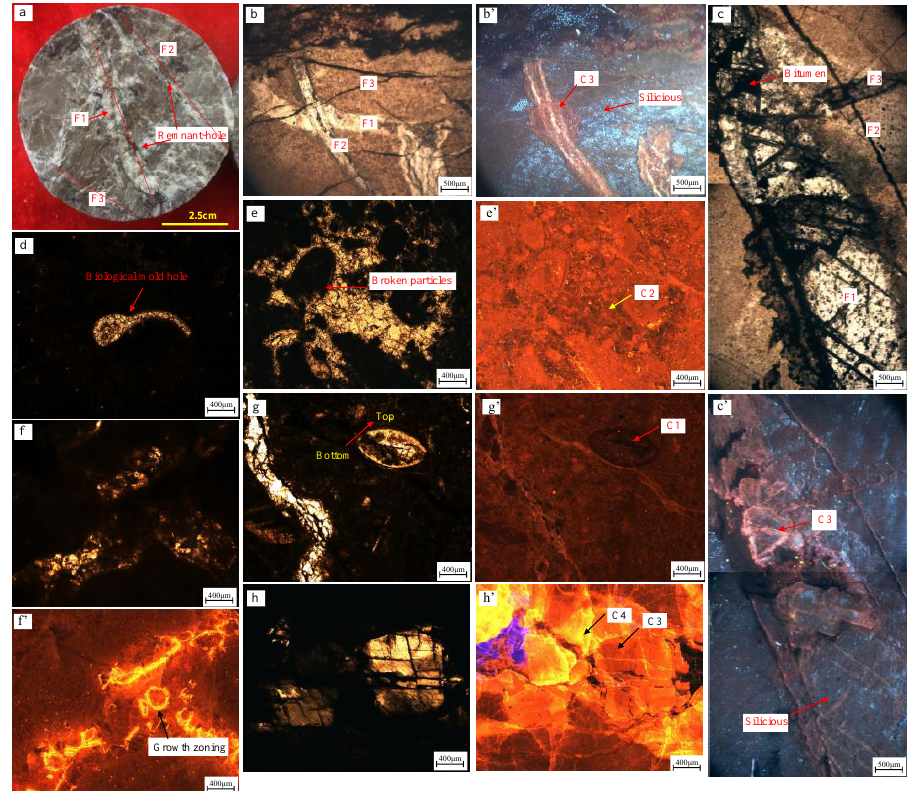
Figure 2. The characteristics of calcite cements from the Ordovician reservoir in the Shunbei area (F1 = the first fracture set; F2 = the second fracture set; F3 = the third fracture set; C1 = the first stage of calcite cement; C2 = the second stage of calcite cement; C3 = the third stage of calcite cement; C4 = the fourth stage of calcite cement. The photomicrographs b, c, d, e, f, g, and h were taken under transmitted light, and the photomicrographs b’, c’, e’, f’, g’, and h’ were taken under cathodoluminescence. ( a ) SHB5-8 well, O 2 yj , 7680.10 m, micritic limestone, fractures filled with calcite cement and bitumen, and bitumen appears in fracture walls and calcite cement veins. Residual pores are well developed; ( b , b’ ) SHB7 well, O 1–2 y , 7428.90 m, silicified micritic limestone, F1 emplaced prior to, and F2 and F3 occur following silicatization; ( c , c’ ) SHB7 well, O 1–2 y , 7728.80 m, silicified micritic limestone, three episodes of fractures developed, F1 filled with bitumen, siliceous and calcite cement, F2 and F3 filled with bitumen; ( d ) SHBL1 well, O 1–2 y , 7436.95 m, micritic limestone, biological moldic pore is filled with calcite cement; ( e , e’ ) SHBL1 well, O 2 yj , 7263.97 m, bioclastic grainstone, grain is broken; ( f , f’ ) SHB52A well, O 2 yj , 7671.86 m, micritic limestone, growth zoning. ( g , g’ ) SHB52A well, O 2 yj , 7674.75 m, dolomitic micritic limestone, geopetal structure; ( h , h’ ) SHB5-8 well, O 2 yj , 7679.10 m, micritic limestone, late stage of calcite cement showing orange CL and bright-yellow CL